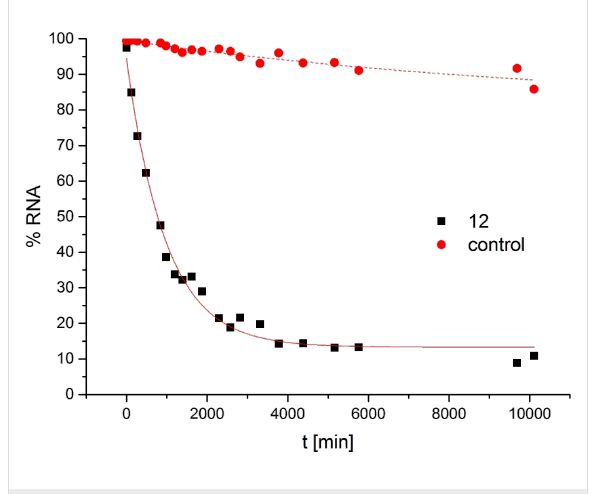
Figure 5: Cleavage kinetics of 15 in the presence and absence of conjugate 12 . Conditions: 150 nM substrate, 0 or 750 nM conjugate, 50 mM Tris-HCl, pH 8, 100 mM NaCl, 37 °C. The solid curves are calculated assuming first order